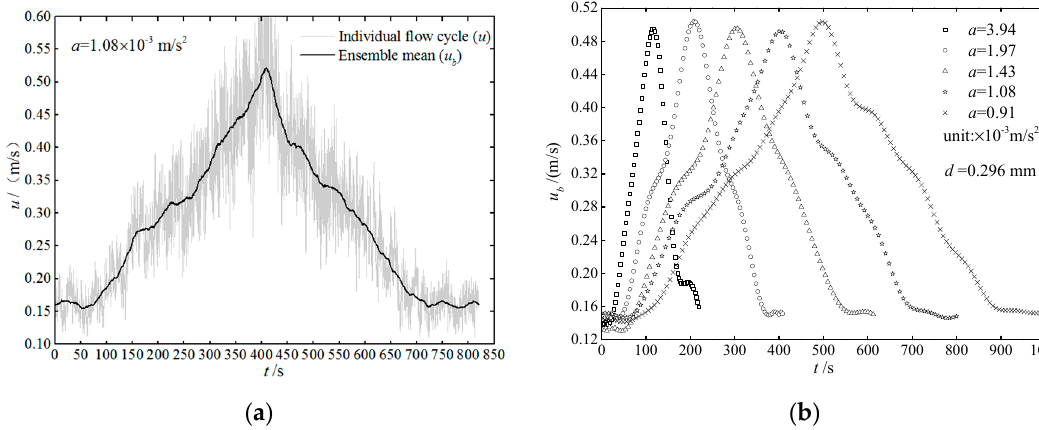
Figure 2. Unsteady flow rate curve under d = 0.296 mm ( a is the velocity skewness, d is the particle diameter). ( a ) Ensemble mean of the flow velocity and ( b ) Variation of flow velocity in different (continuous lines).